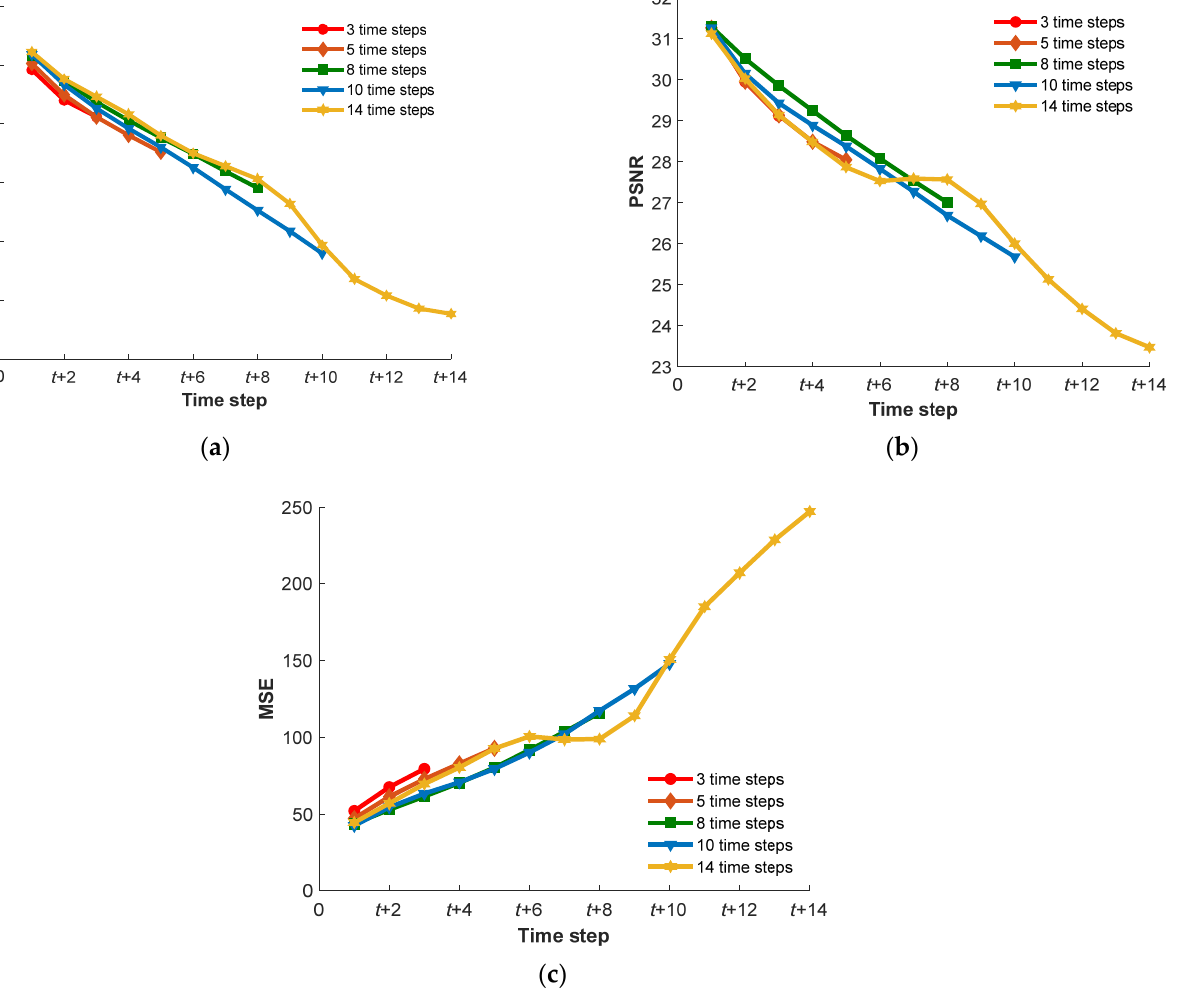
Figure 12. Average evaluation results of MSE ( a ), PSNR ( b ), and SSIM ( c ) at each time step on the Panicoid Phenomap-1 dataset, where the number of prediction steps was set as 3, 5, 8, 10, and 20.